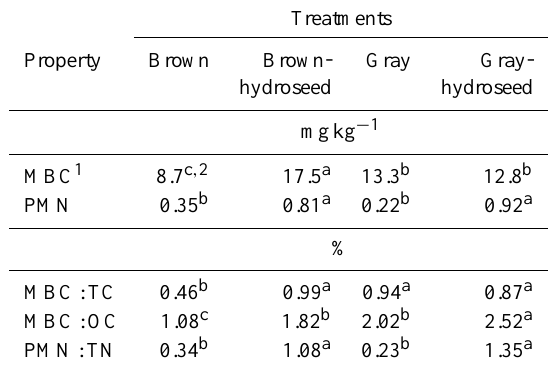
Table 7. Biochemical properties and ratios for mine soils after six growing seasons at the Birch River Operation in Webster